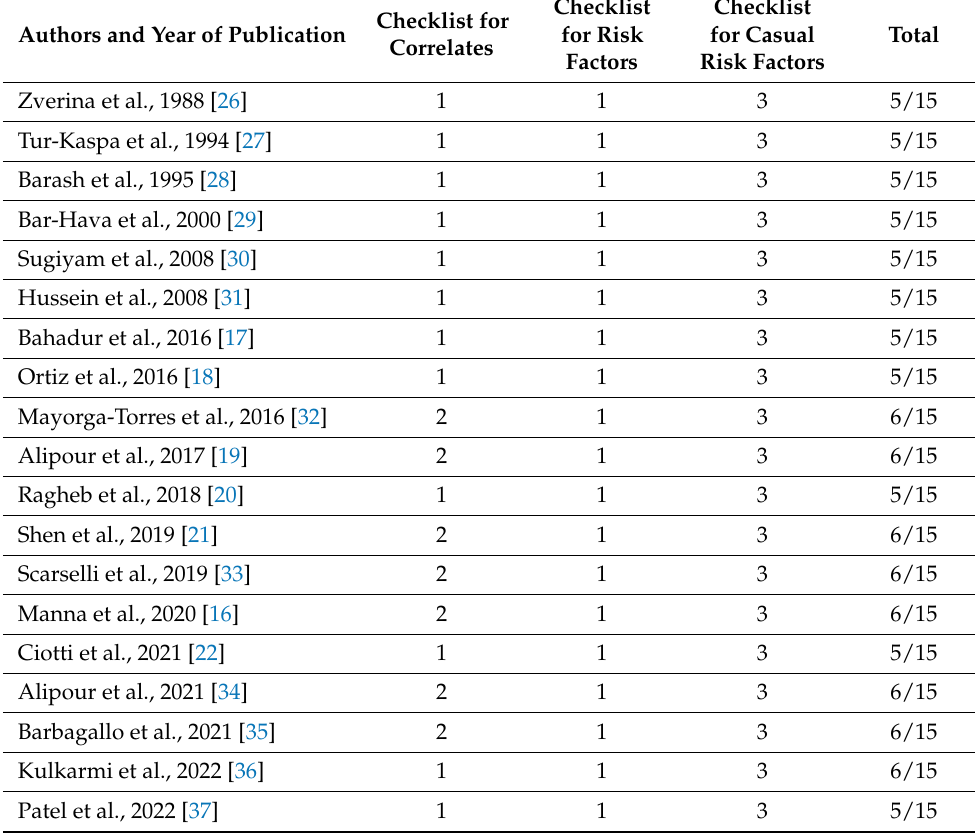
Figure 1. Flowchart of studies included. Table 2. Evaluation of study quality using “The Cambridge Quality Checklists”.